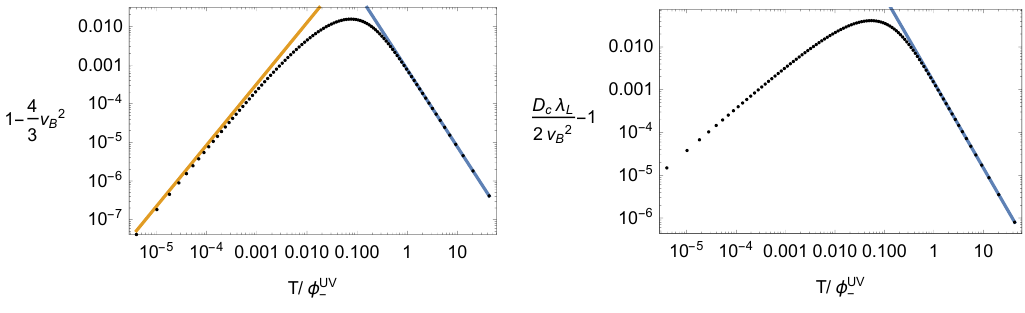
Figure 7 . Quantities 1 (cid:0) 4 calculation and lines are results of perturbation